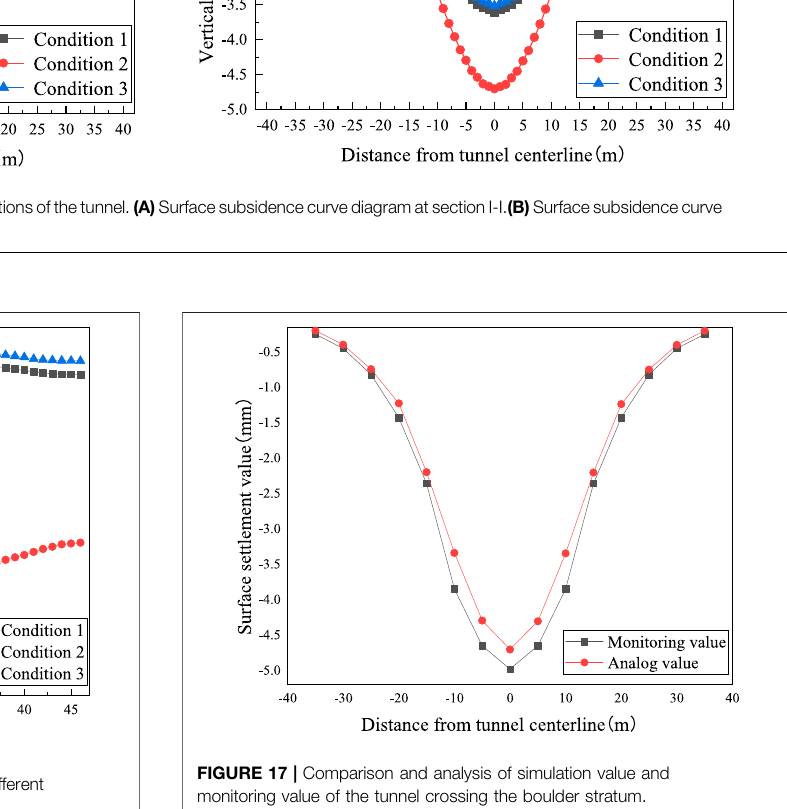
Frontiers in Earth Science |